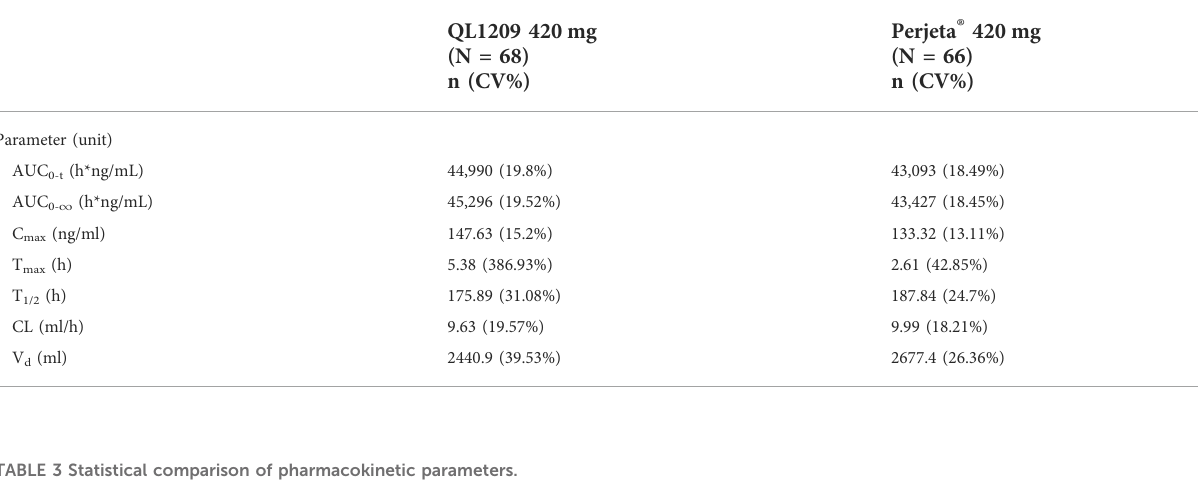
TABLE 2 Summary of pharmacokinetic parameters for QL1209 and Perjeta ® .